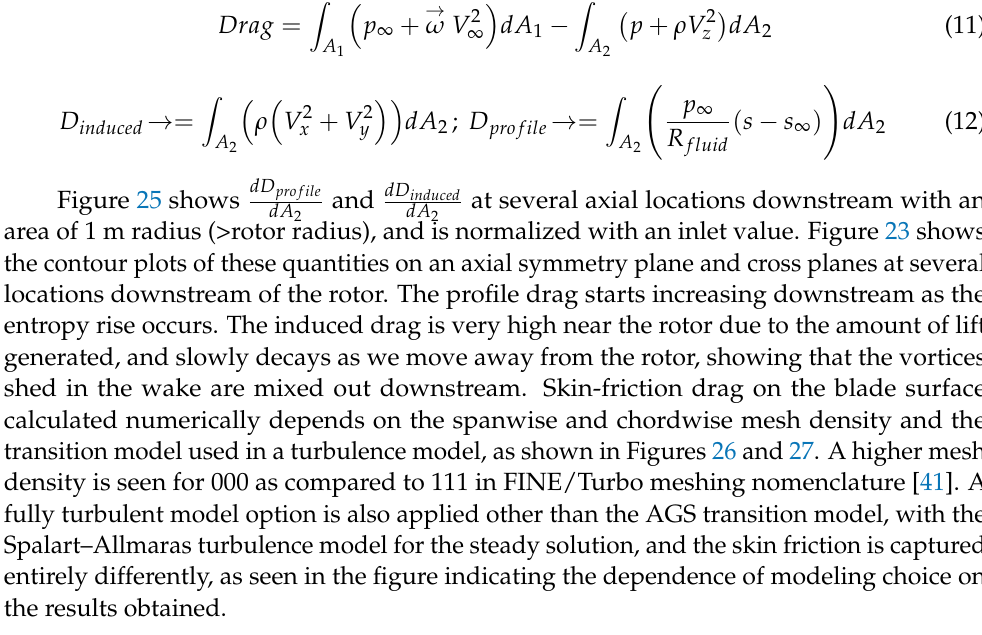
Figure 26. Skin-friction contours in the top 15% span of the suction side, showing mesh density for several 3D domain sizes and transition models of the solo propeller rotating downwards.